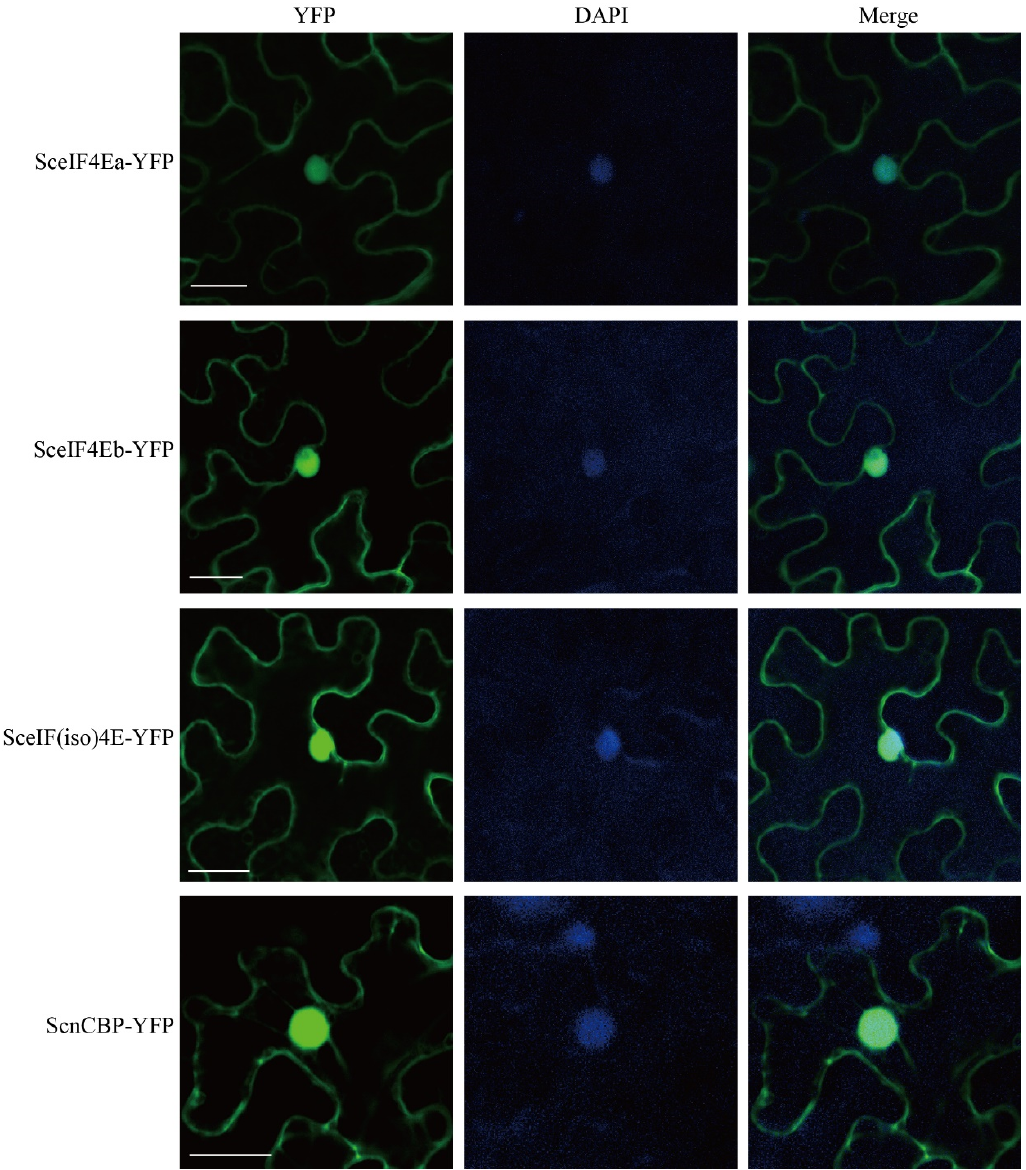
Figure 4. Subcellular localization of SceIF4Ea, SceIF4Eb, SceIF(iso)4E, and ScnCBP in Nicotiana benthamiana leaf epidermal cells. Fluorescence of YFP or YFP fusion proteins was detected by 48 h post agroinfiltration. The nucleus was displayed by diamidine phenylindole (DAPI) staining. Bars = 25 μ m.